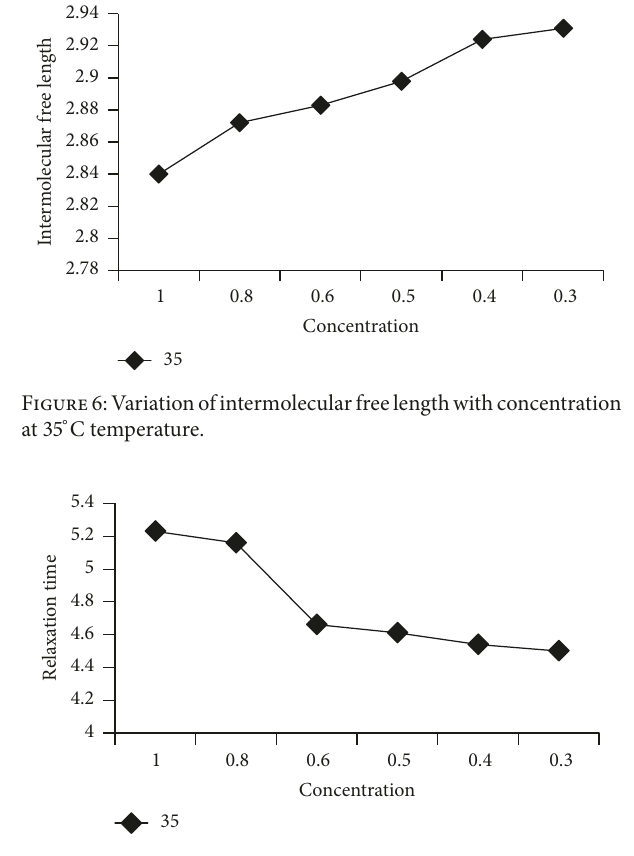
Figure 7: Variation of relaxation time with concentration at 35 ∘ C temperature.